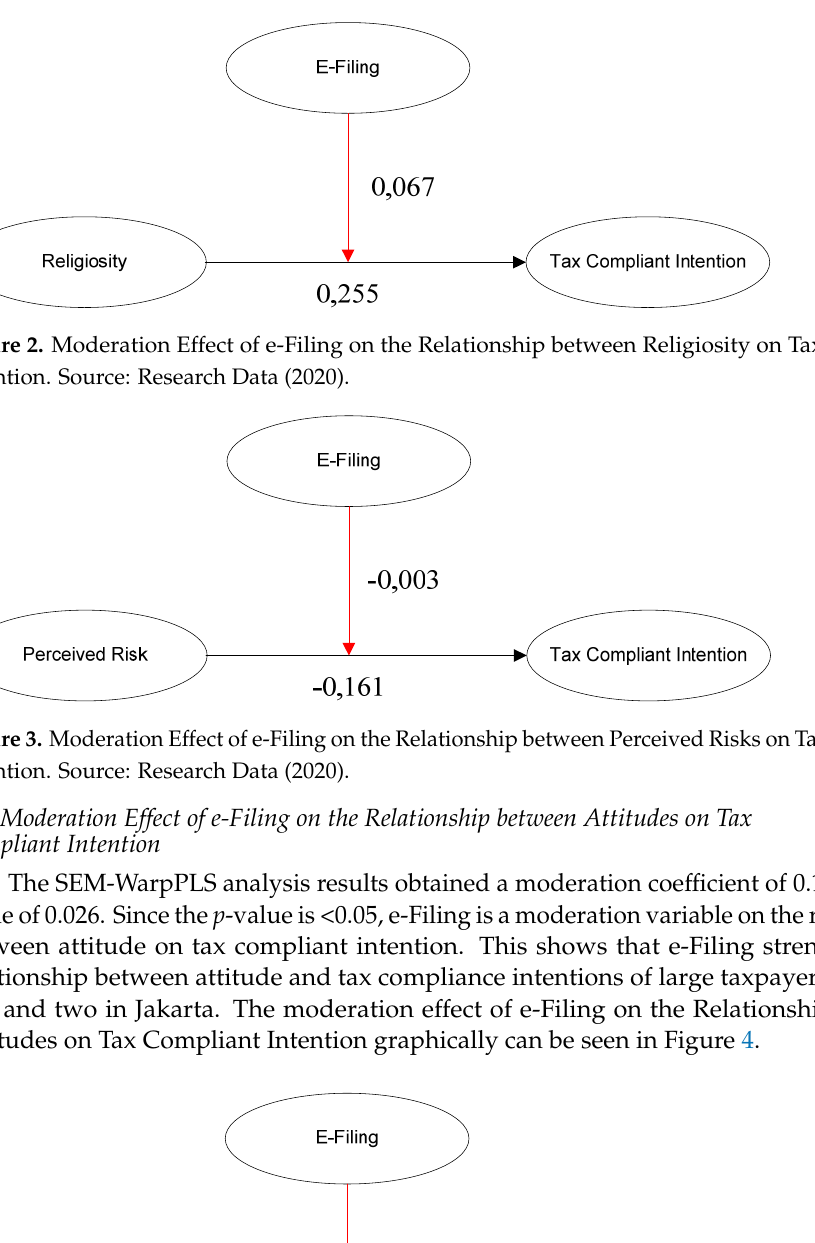
Figure 3. Moderation Effect of e ‐ Filing on the Relationship between Perceived Risks on Tax Com ‐ pliant Intention. Source: Research Data (2020).